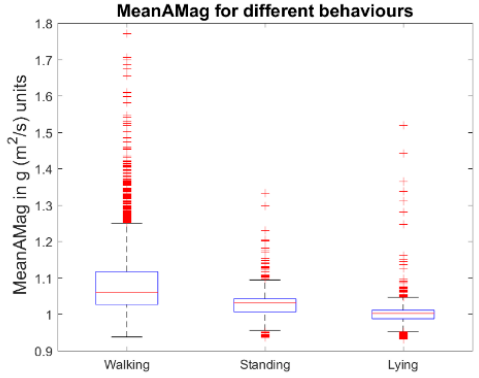
Figure 3. Boxplot of the MeanAMag across the different behaviours.